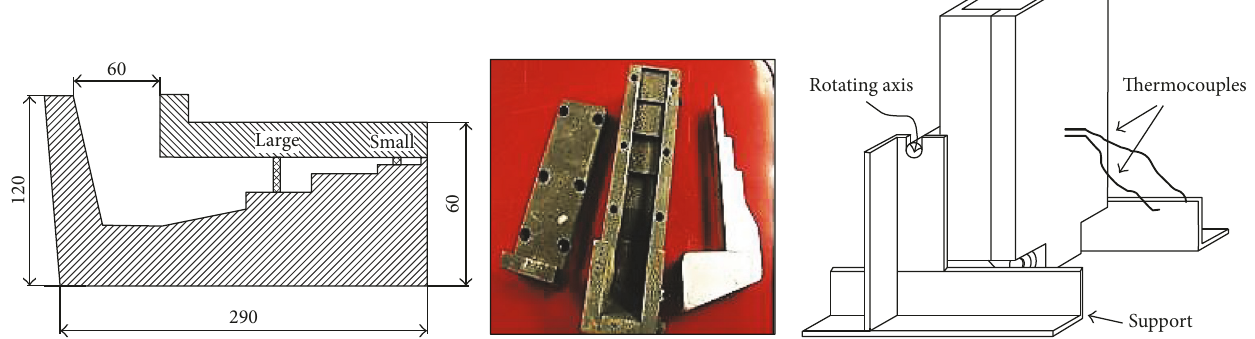
(d) Setup showing the variable angle mold used for carrying out thermal